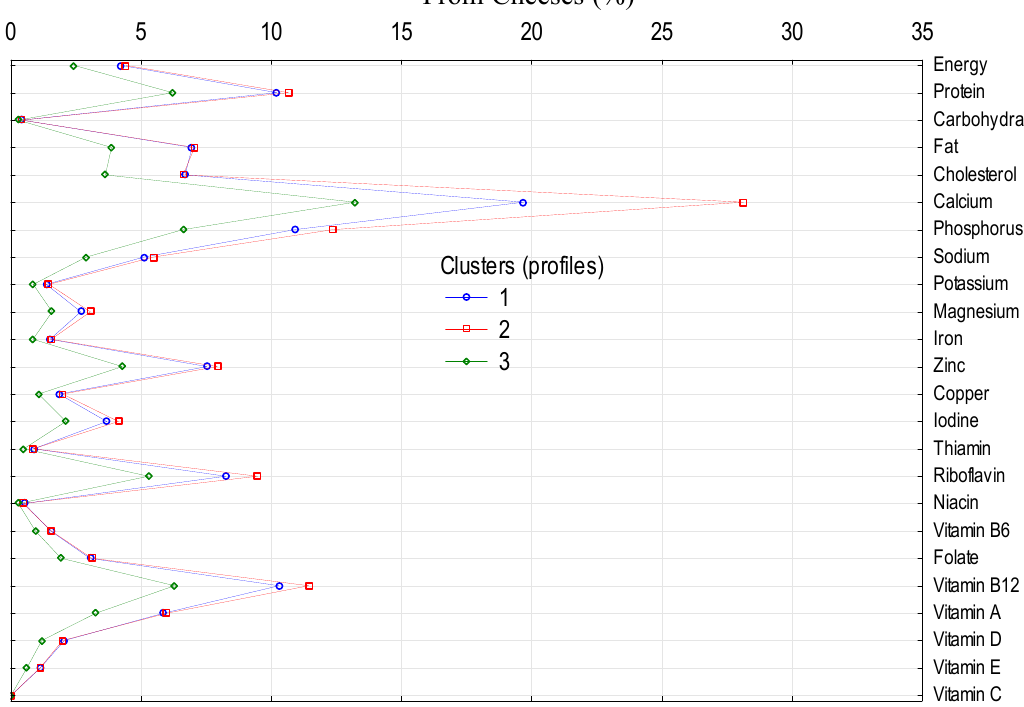
Figure 2. Cluster analysis: supply of energy and nutrients from cheeses to the average Polish diet. 239